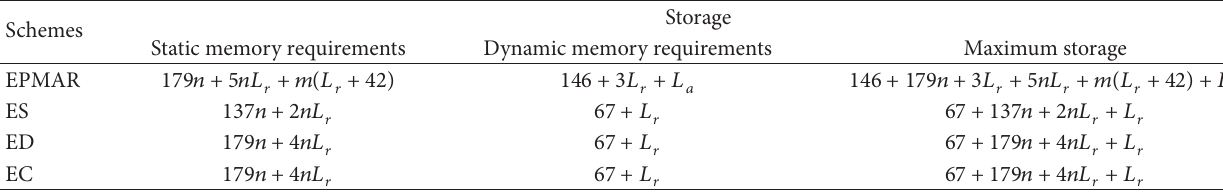
Table 3: Storage requirements of phone (bytes).